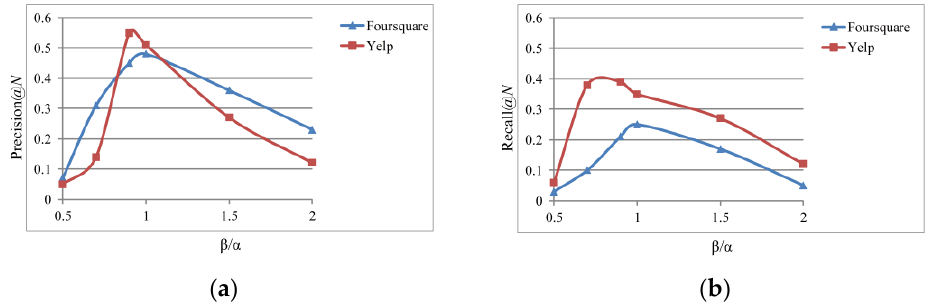
Figure 7. Parameter effect on α and β : ( a ) Precision on CGTS-HAN; ( b ) Recall of on CGTS-HAN.